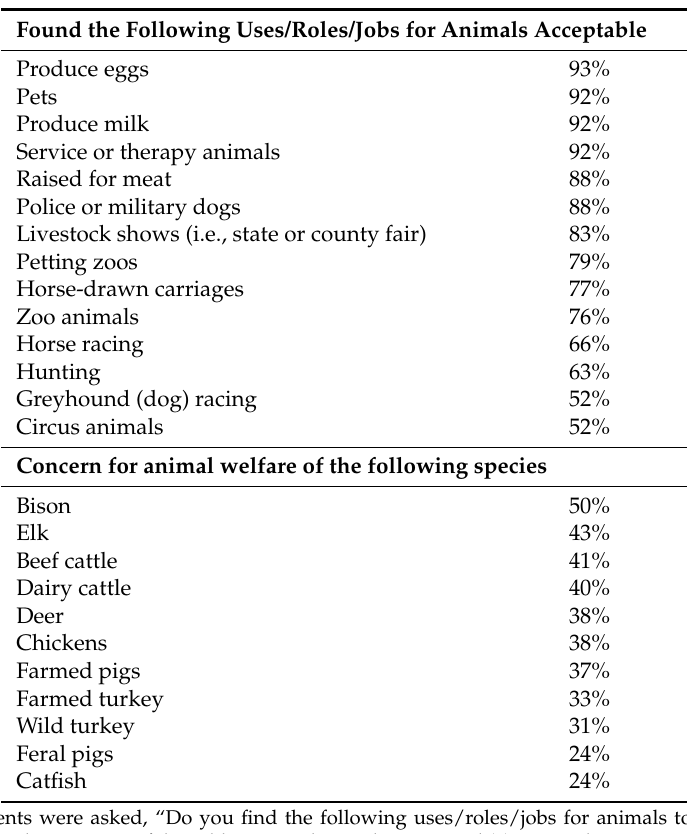
Table 2. Responses to finding animal uses